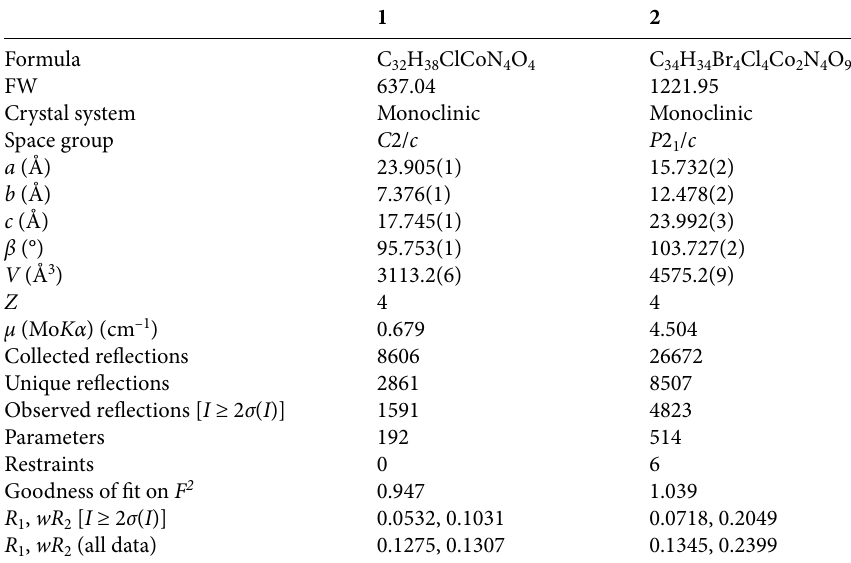
Table 1. Crystallographic and refinement data for the